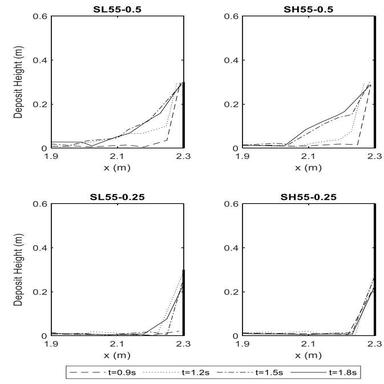
Static zone at the front of the element.